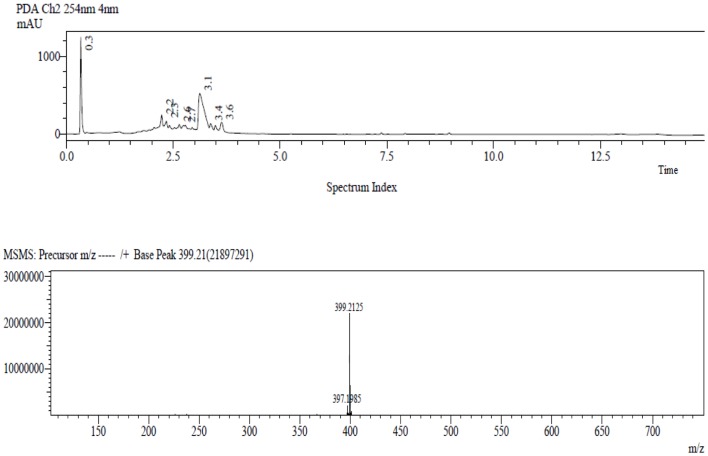
The LC-MS chromatogram of the target compound, mitragynine, with molecular mass m/z (+) 399.2 was detected at 3.1 min.